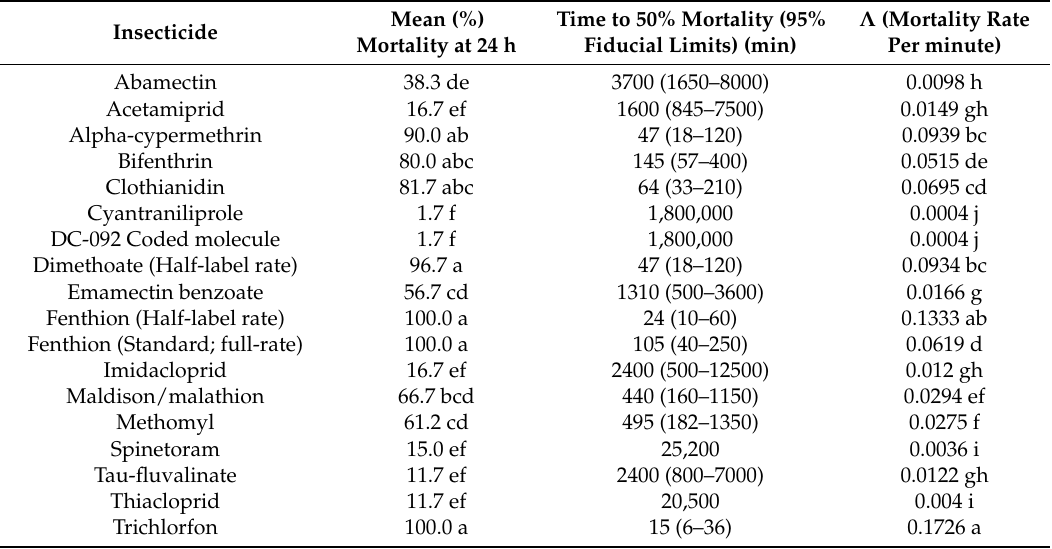
Table 4. The mean percentage mortality at 24 h, time to reach 50% mortality, and the instantaneous mortality rate ( λ ) of adult Bactrocera tryoni exposed to filter paper dipped in insecticide (bioassay 1). Weibull’s shape parameter α = 0.52.